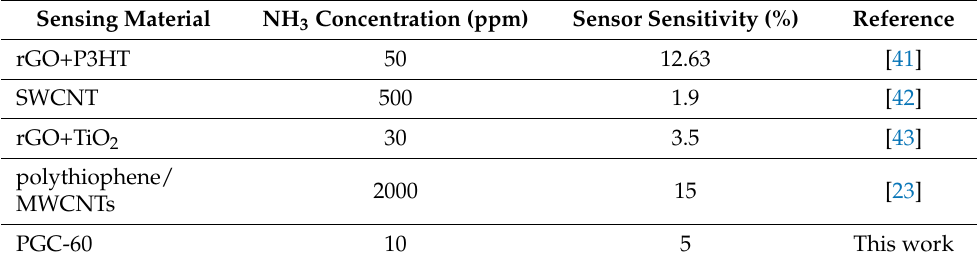
Table 1. PGC-60 ammonia sensor sensitivity in a comparison with literature data.